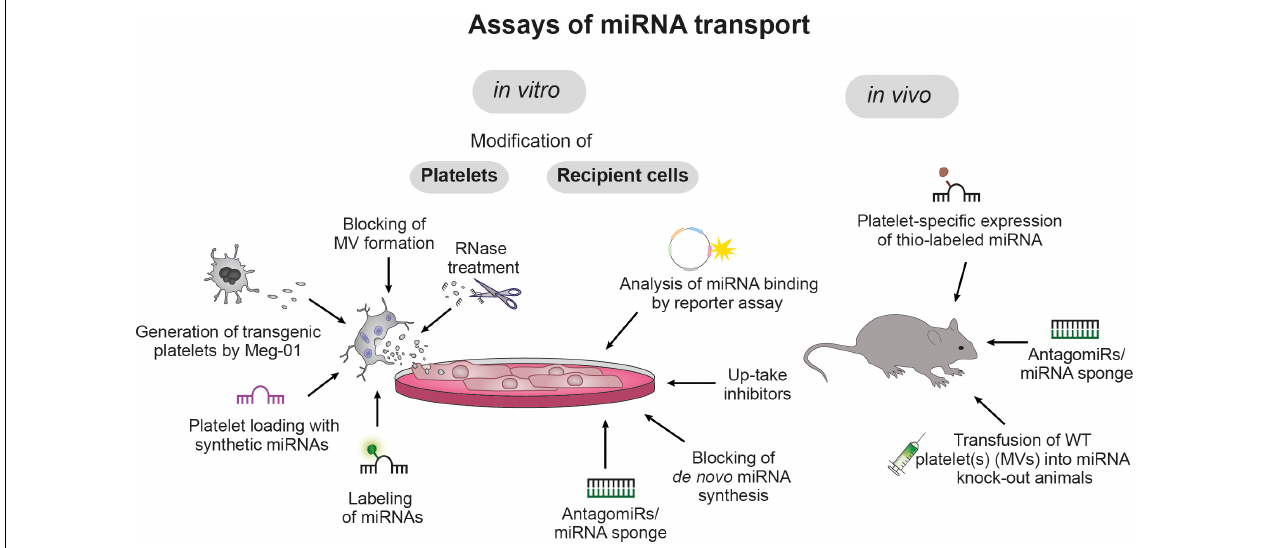
FIGURE 2 | Assays of miRNA transport. Currently, platelet-mediated transfer of miRNAs is studied in vitro and in vivo with various molecular and genetic tools that allow targeting of platelets, recipient cells and miRNAs: Platelets can be loaded with synthetic or labeled miRNAs, microvesicle (MV) release can be blocked with brefeldin A and platelet RNA can be degraded via RNase treatment. Moreover, the megakaryoblast cell line Meg-01 allows in vitro production of genetically modified platelets. In recipient cells, uptake of platelet-derived miRNAs can be blocked by specific inhibitors (e.g., targeting of PLA2IIA) and binding of miRNAs to the recipient cell RNA can be prevented by co-incubation with short target site-specific anti-sense antagomiRs or miRNA sponges, which harbor multiple miRNA target sites. Furthermore, blocking de novo miRNA synthesis in recipient cells allows to distinguish between endogenous and transferred miRNAs and the inhibitory potential of miRNAs can be quantified by reporter assays. In vivo studies take advantage of genetically or pharmacologically modified mice to study in vivo miRNA